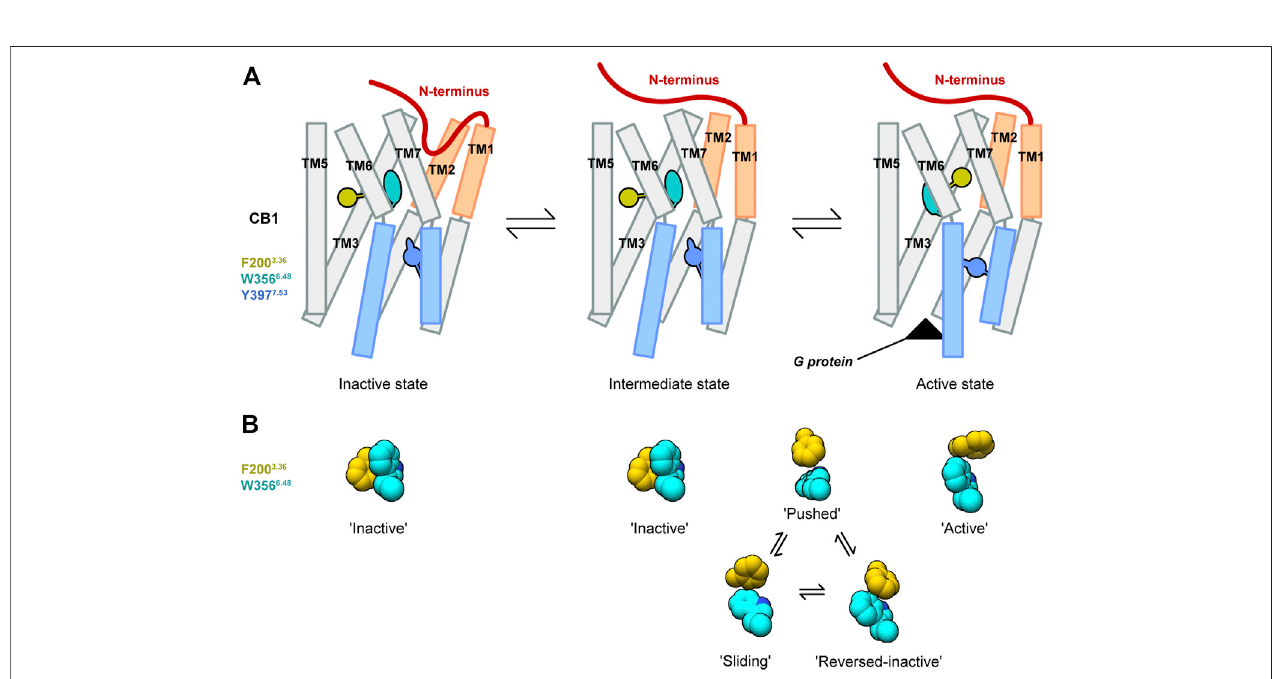
FIGURE6| ModeloftheCB1activationmechanism. (A) ShowedtheoverallCB1receptor. (B) Showedcon fi gurationsofthe “ twintoggleswitch ” residuesF200 3.36 and W356 6.48